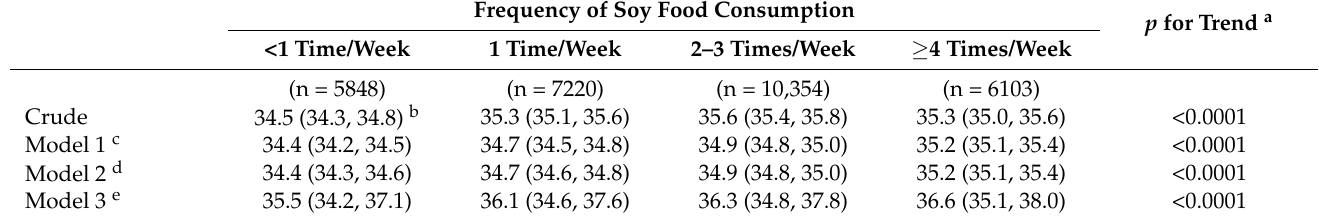
Table 2. The association between frequency of soy food consumption and handgrip strength (n = 29,525).